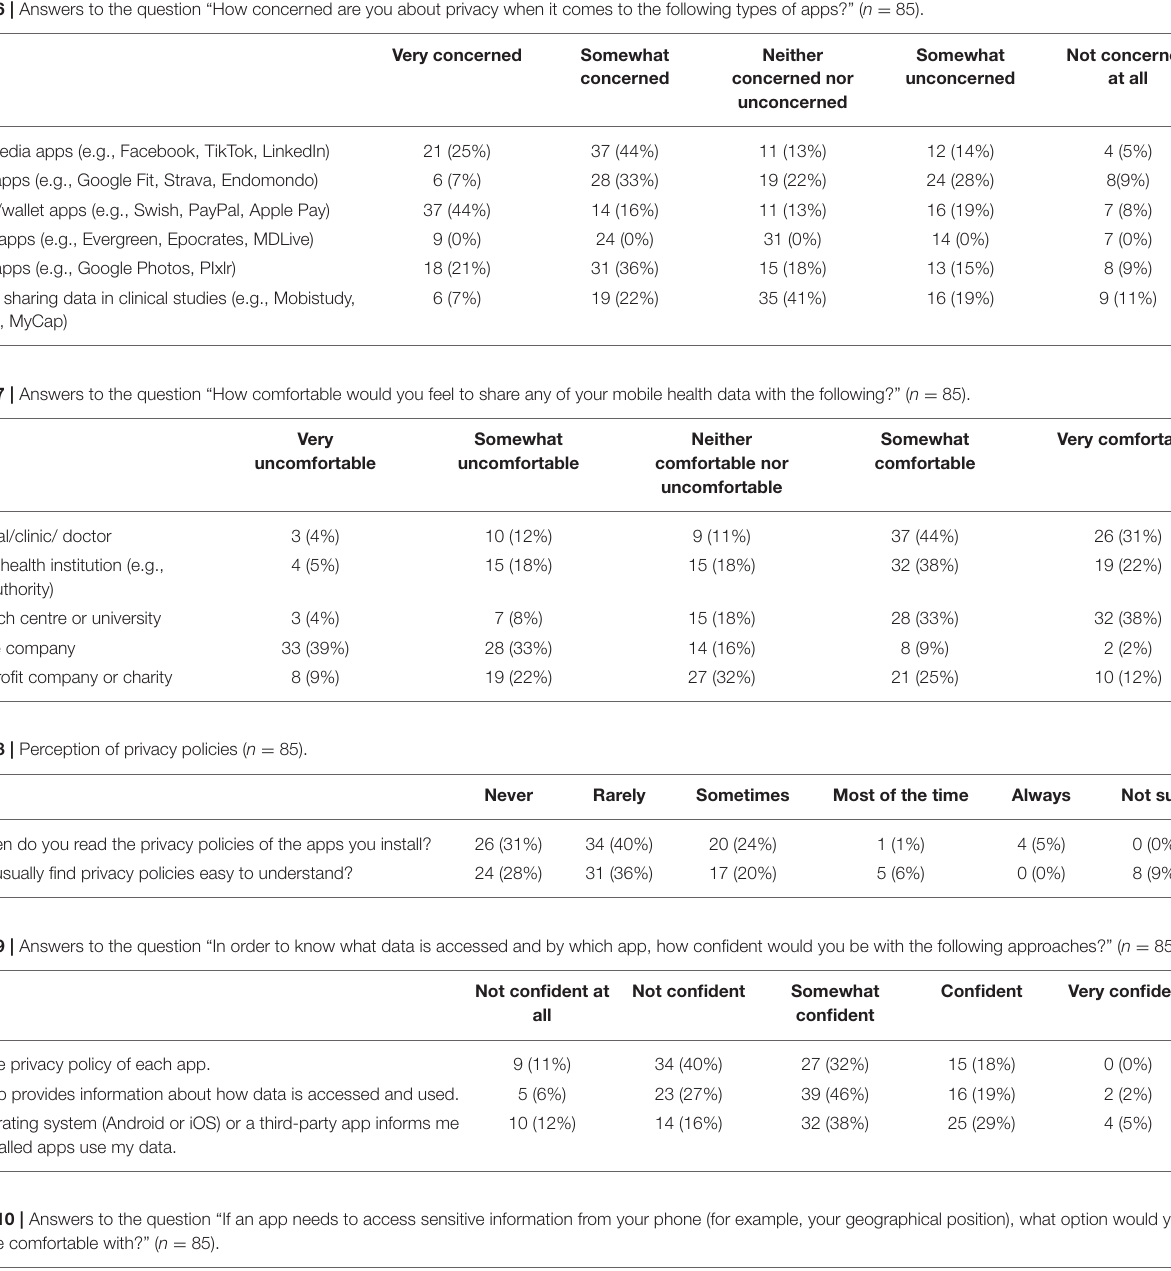
Not comfortable at